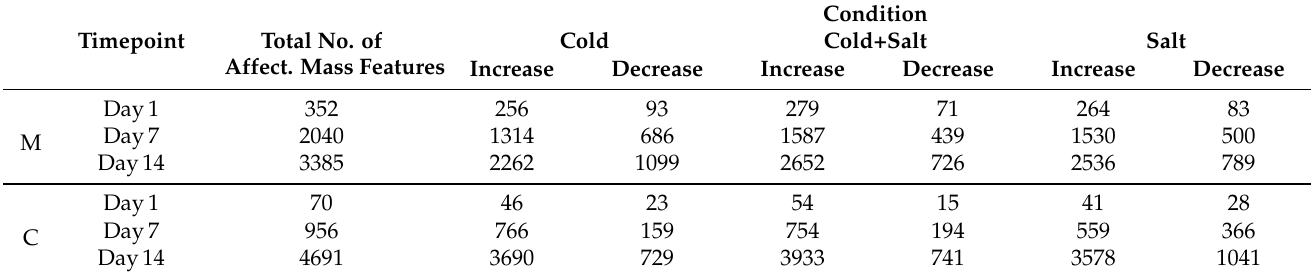
Table 2. Increasing numbers of (unknown) mass features affected by stress treatments over the harvest period in Mazurka and CAP1035. Spectra of all samples were analyzed regarding m / z , retention time and peak area. Compounds detected in stressed samples were compared with the respective control